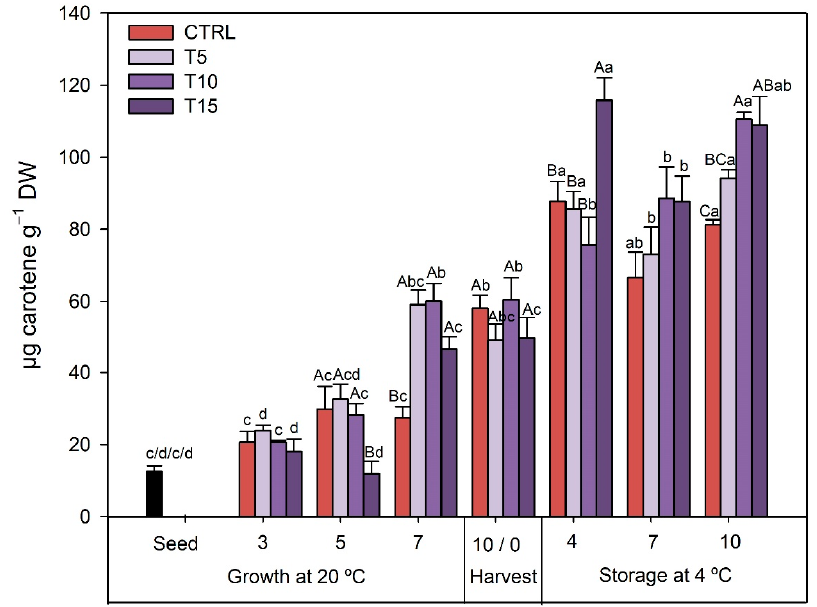
Figure 6. Total carotenoid content of control (0, CTRL) or UV-B treated (5, 10, and 15 kJ m − 2 ) red cabbage sprouts after 10 days growth at 20 °C and stored 10 days at 4 °C after harvest. Different capital letters indicate significant differences among treatments at p < 0.05 according to Tukey’s test ( n = 6, that were the plates collected, and each plate is a repetition). Different lowercase letters indicate significant differences among time of analysis of the same treatment at p < 0.05 according to Tukey’s test.